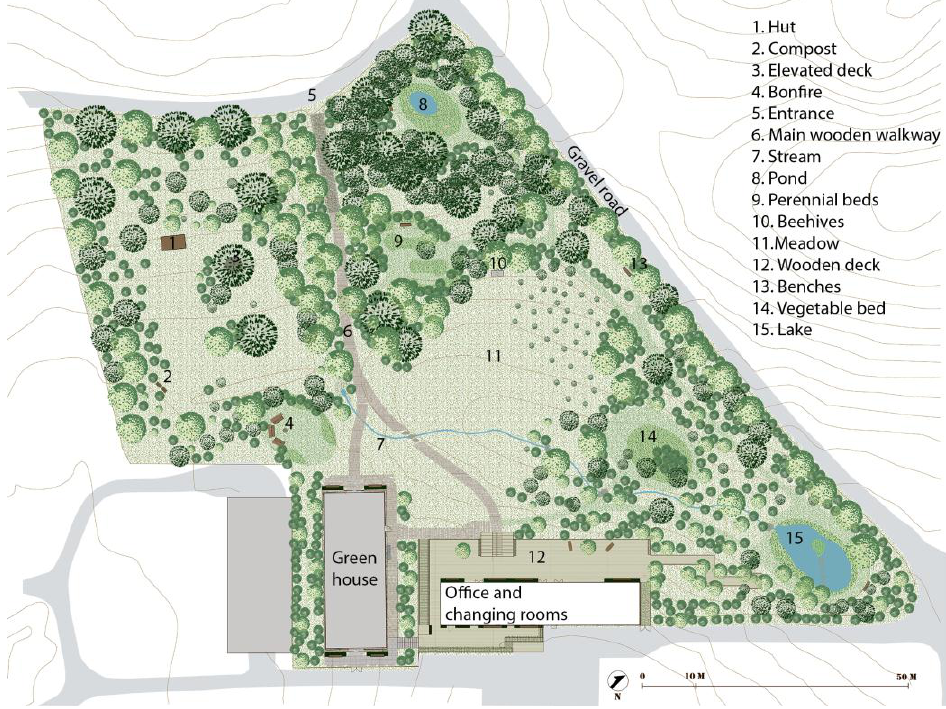
Figure 3. Plan of Nacadia ® detailing its main physical components.